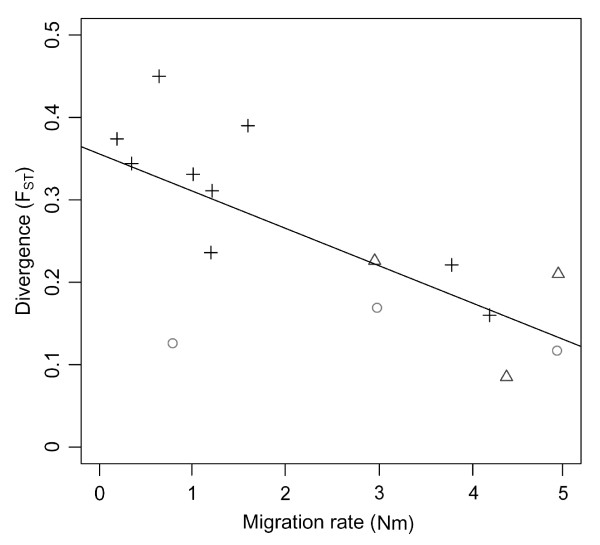
Correlation between population divergence (FST) and inter-deme migration (Nm). African population pairs are indicated by circles, non-African population pairs by triangles, and African/non-African population pairs by crosses.